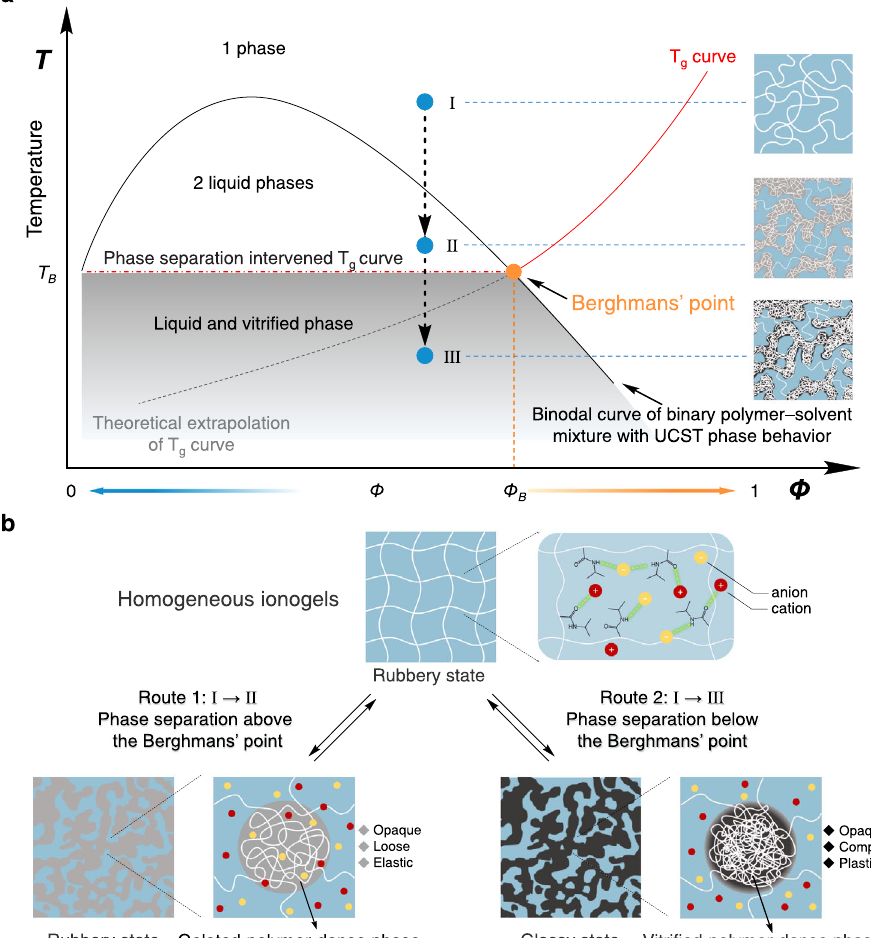
Fig. 1 | Stiffness-changing mechanism of polymer networks. a An illustrative phase diagram of solvent-polymer demixing interferes with the glass transition of the polymer.The brokenlineisthetheoreticalextrapolationofthe glasstransition line.Atlowerpolymerconcentrations( Φ < Φ B ),aconcentration-independentglass